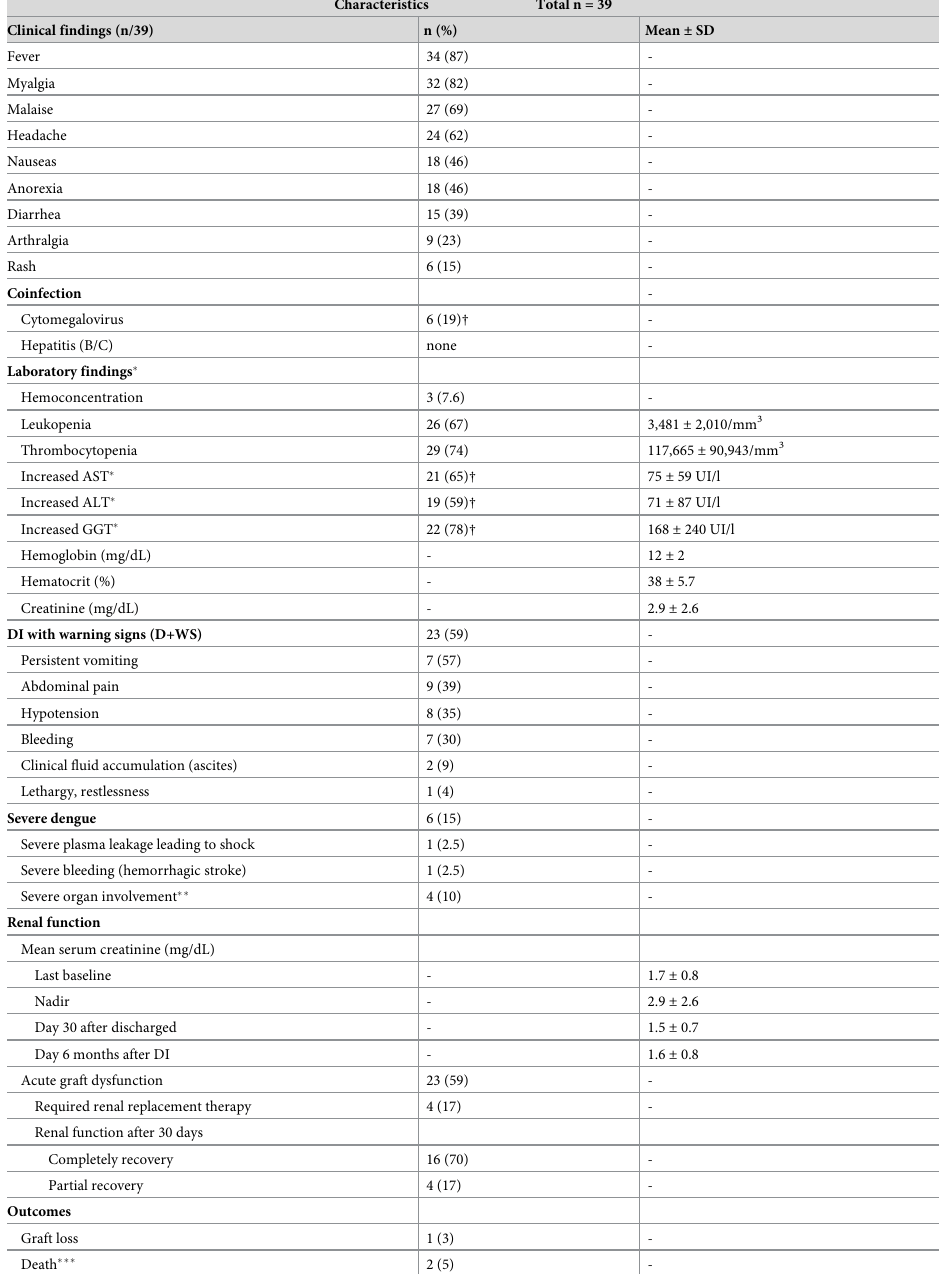
Table 2. Clinical Characteristics of Dengue Infection in KTx at